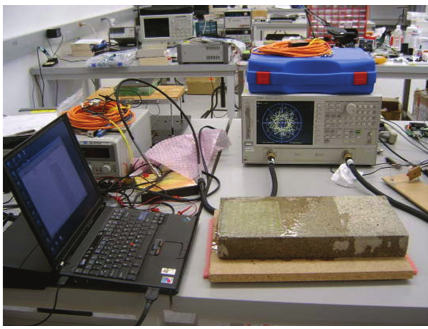
Figure 1: Setup for EM measurement.